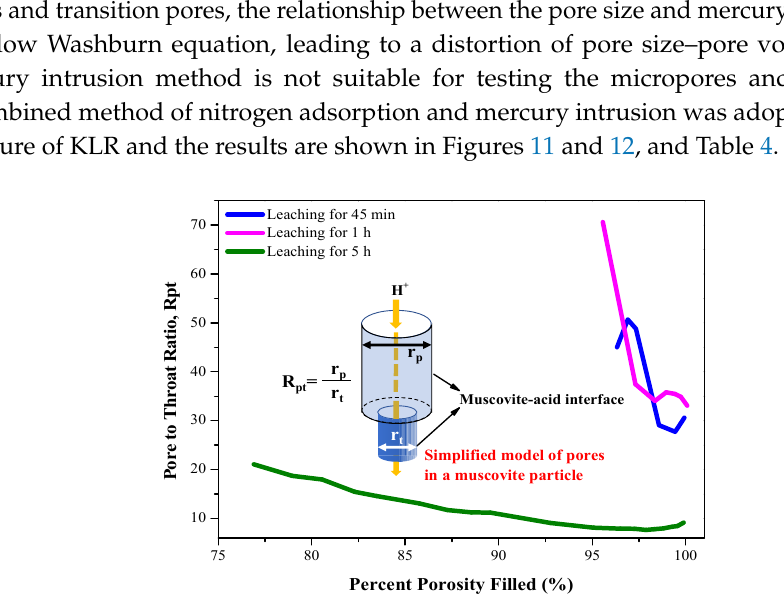
Figure 11. Pore to throat ratio of the KLR obtained after leaching at 45 min, 1 h, and 5 h with 4mol/L H 2 SO 4 and 7 wt% K 2 SO 4 under 150 °C (r p and r t respectively represent the pore size and the pore throat size that is the diameter of the thinnest part in porous channel).